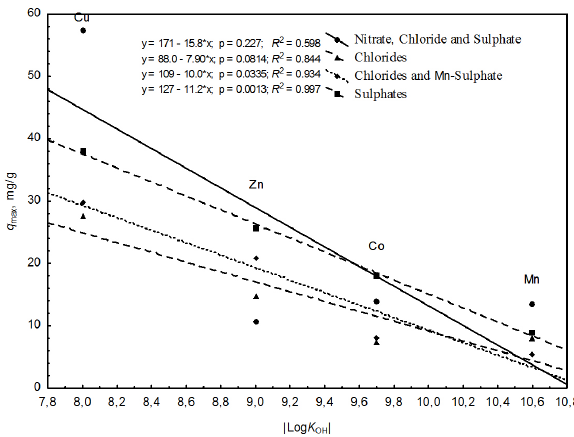
Figure 4: The correlation between biosorption capacity and the absolute value of the constant for the first stage of hydrolysis |Log K OH